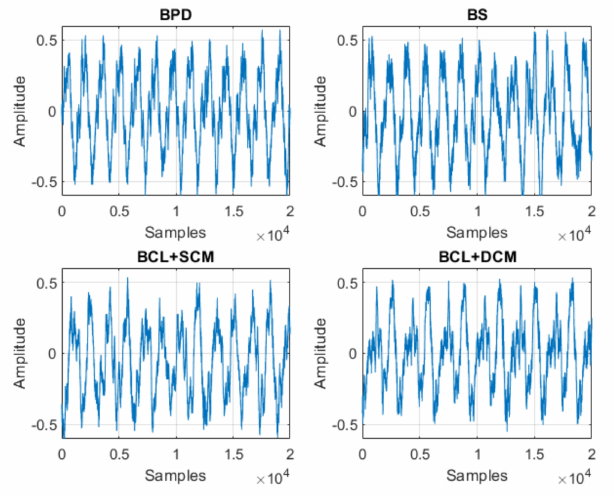
Figure 21. Samples of the studied signals—BPD, BS, BCL + SCM and BCL + DCM.